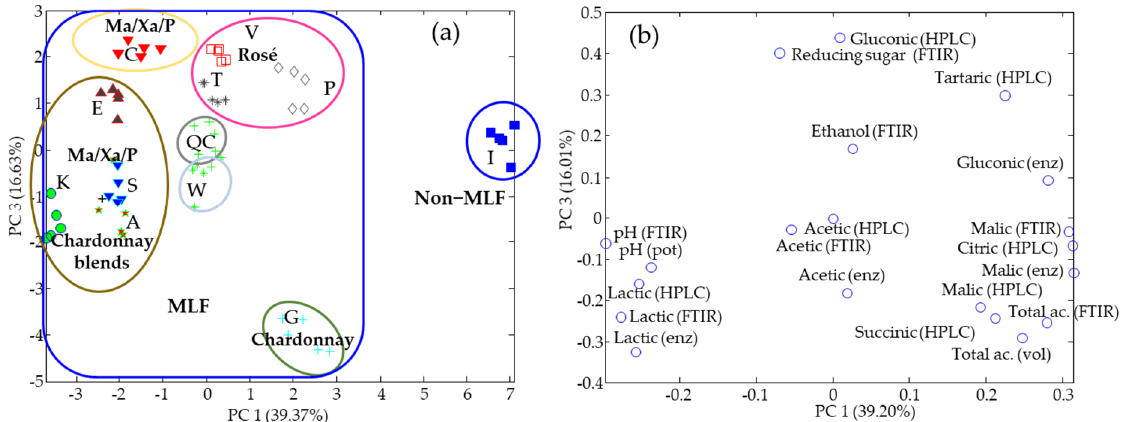
Figure 2. PCA results from the study of organic acids and related data. Plot of scores ( a ) and plot of loadings ( b ). Cava class assignation: see Table 2.